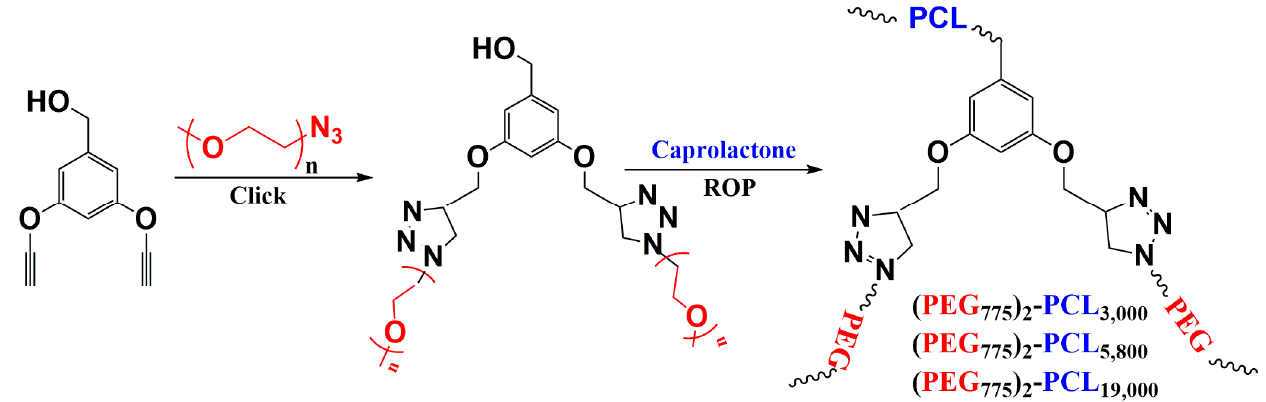
Figure 17. Controlled synthesis of miktoarm A 2 B copolymers with various PCL chain